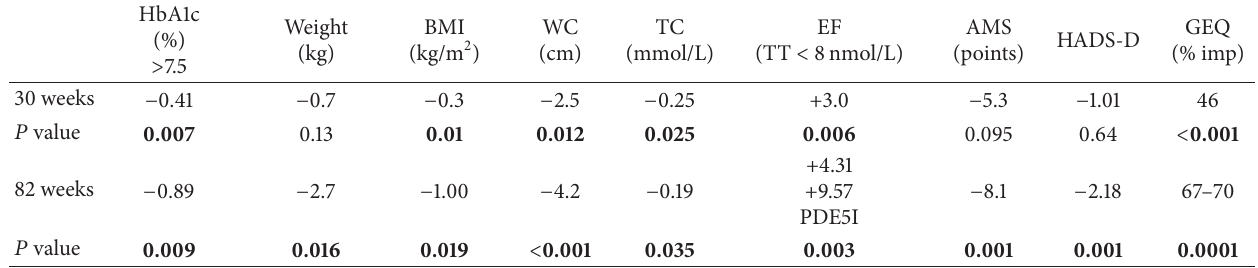
Table 3: Outcome of therapy with long acting TU in a population of men with type 2 diabetes and hypogonadism (BLAST) Hackett et al. IJCP Dec 2013